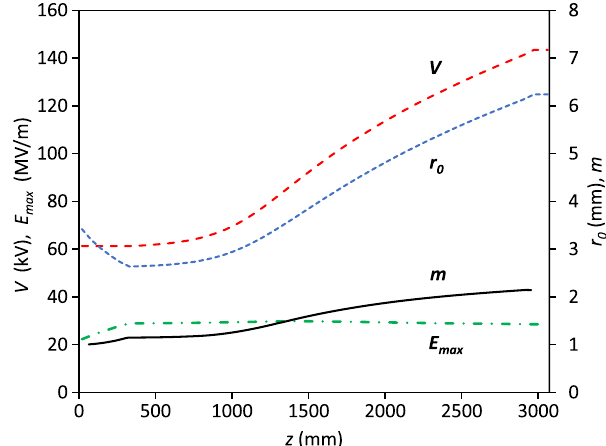
FIG. 1. Cell parameters of epRFQ as functions of the longi- tudinal position z for V , E , r 0 , and modulation factor m max